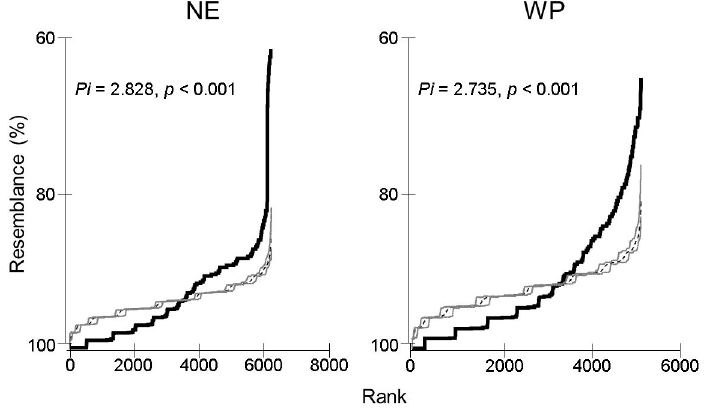
Figure 5. Similarity profiles (SIMPROF) for the traits matrix at each ecozone (NE = Nearctic, WP = Western Palearctic). The profile shows the ordered similarities between sites plotted against their real ranks (black thick continuous line) and permuted data (mean of the 999 permuted matrices in black thin dashed line and 99% confidence intervals in grey lines). In both cases, higher similarities between site pairs were observed less than expected by chance (lower ranks), while the opposite was true for lower similarities (higher ranks). The statistics (Pi) and p -values are provided.